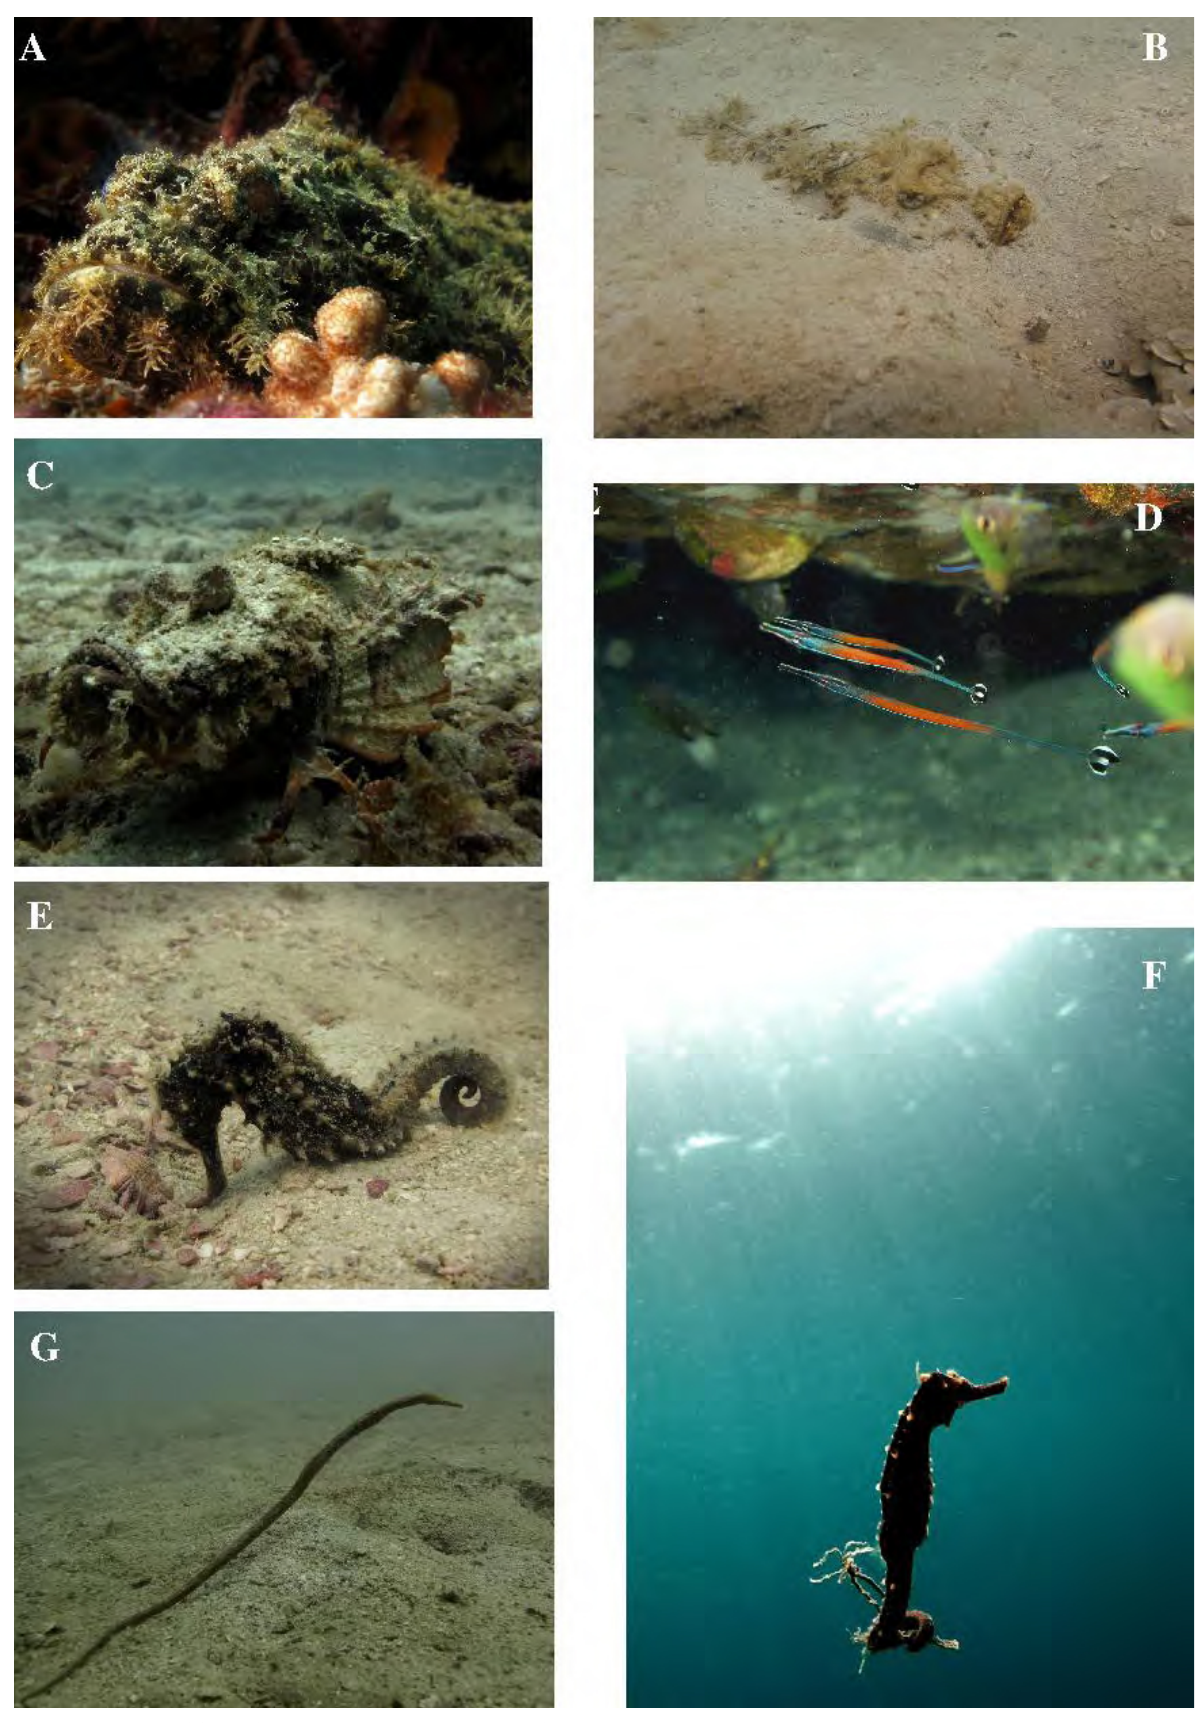
New records of fishes from Koh Tao: